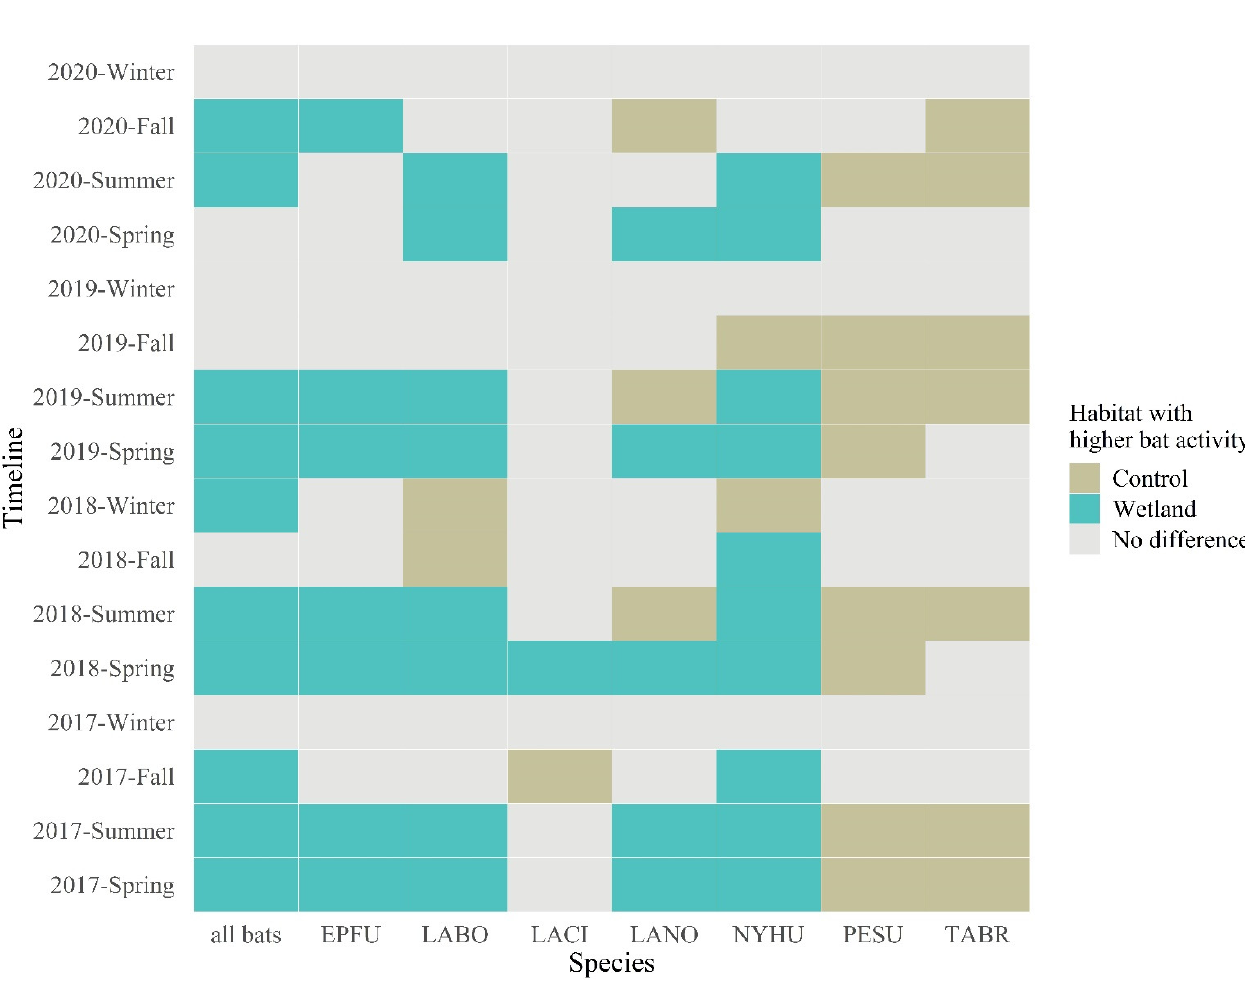
Figure 2. Tile plot showing in different seasons whether the woody wetland or the woody control had higher total and species-specific bat activity in the Peabody Park in Greensboro, North Carolina, USA. Statistical significance was determined by Wilcoxon tests.